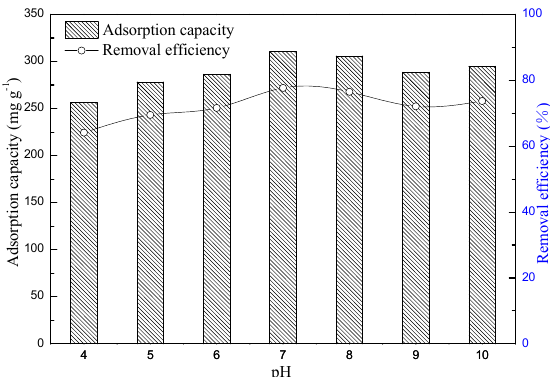
Figure 5. Effect of pH on the adsorption capacity and removal efficiency of BSNC-800-4; left y-axis Figure 5. E ff ect of pH on the adsorption capacity and removal e ffi ciency of BSNC-800-4; left y-axis represents the adsorption capacity, right y-axis represents the removal efficiency. represents the adsorption capacity, right y-axis represents the removal e ffi